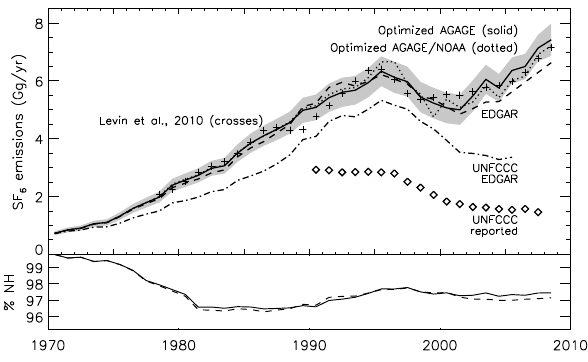
Fig. 2. Optimized global SF 6 emissions derived using AGAGE data only (solid line) and AGAGE and NOAA-ESRL data (dotted line). EDGAR v4 emissions are shown as a dashed line, with UNFCCC- reported emissions as diamonds, and EDGAR v4 estimates of UN- FCCC emissions as the dash-dotted line. Shaded areas show the 1- σ uncertainties in the optimized AGAGE-only emissions. Levin et al. (2010) top-down emissions are shown as crosses. UNFCCC reported emissions have been adjusted prior to 1995 as per Levin et al. (2010). The lower panel shows the percentage emission in the NH, according to our AGAGE-only inversion (solid) and EDGAR v4